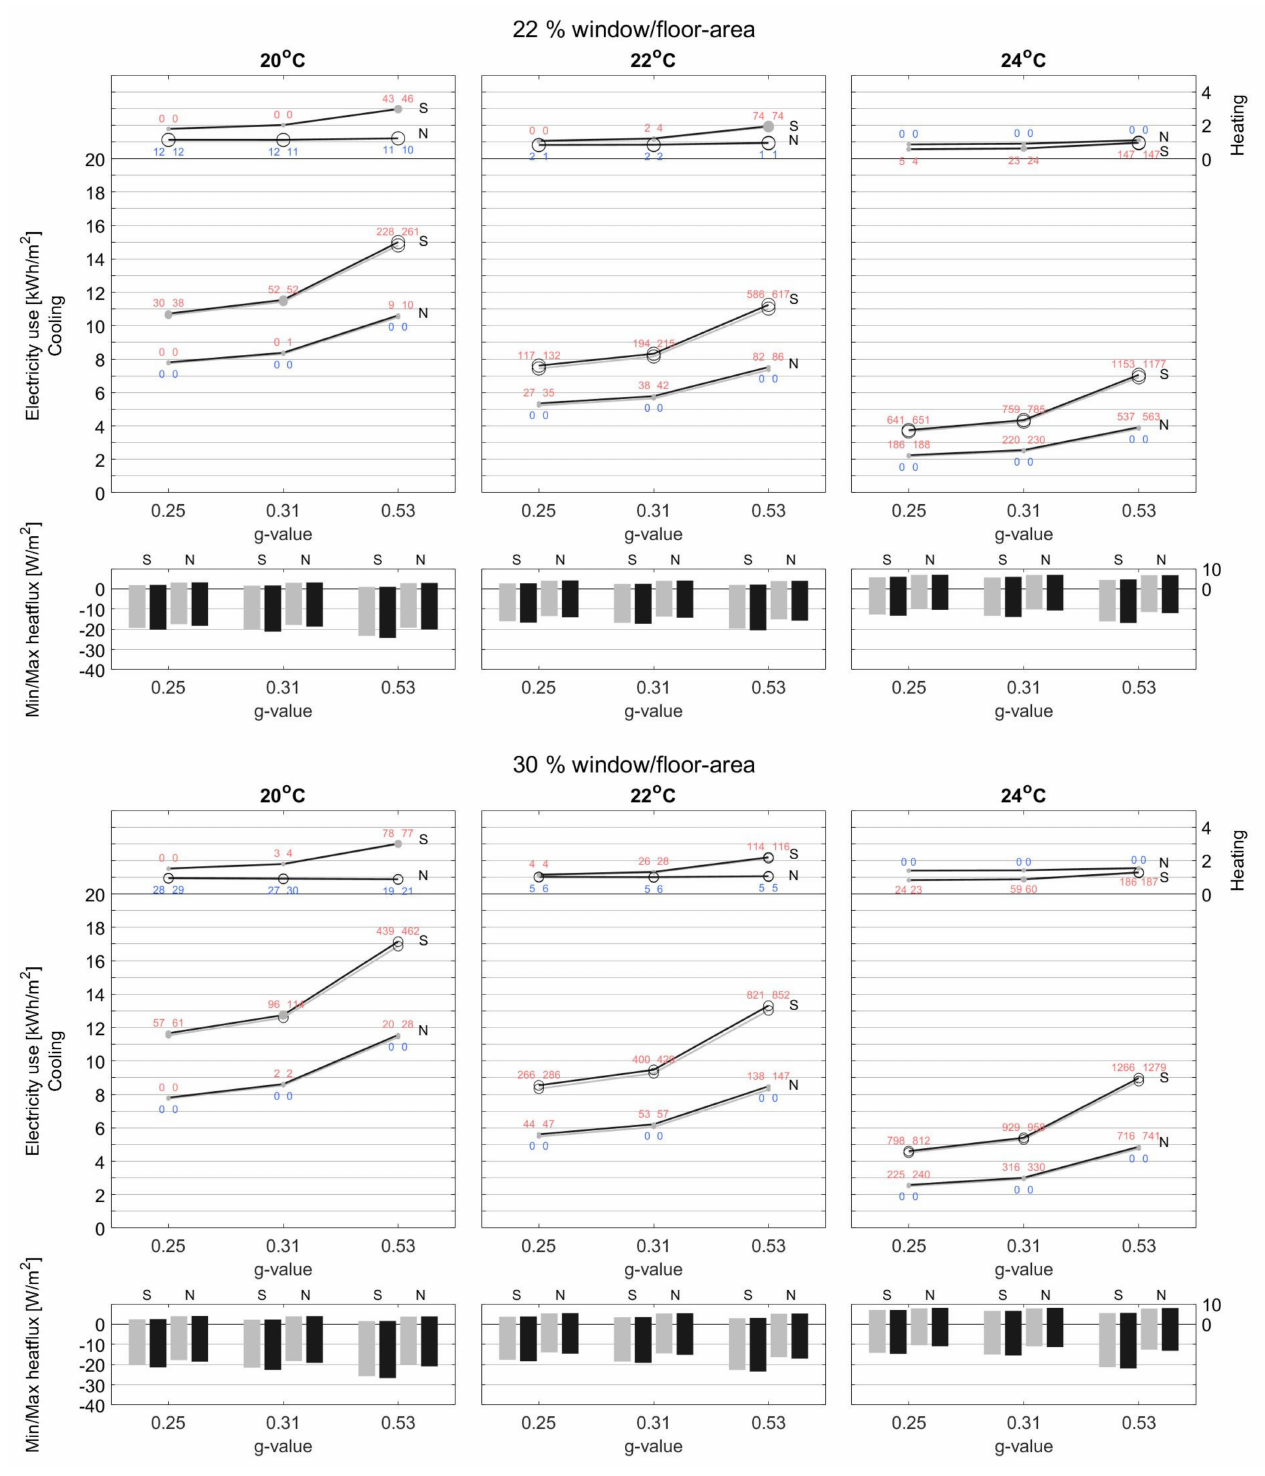
Figure A4. Copenhagen